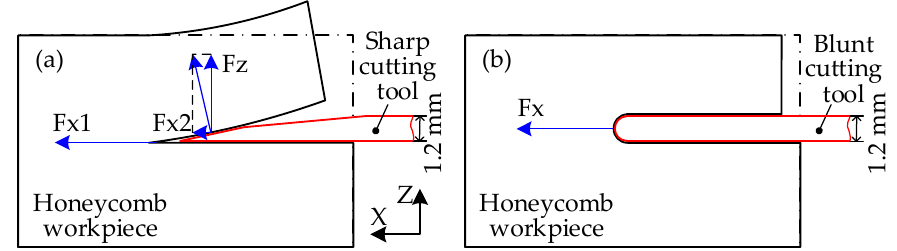
Figure 7. Free-body diagrams of honeycomb cutting with different cutting tools: ( a ) sharp cutting tool; ( b ) blunt cutting tool.